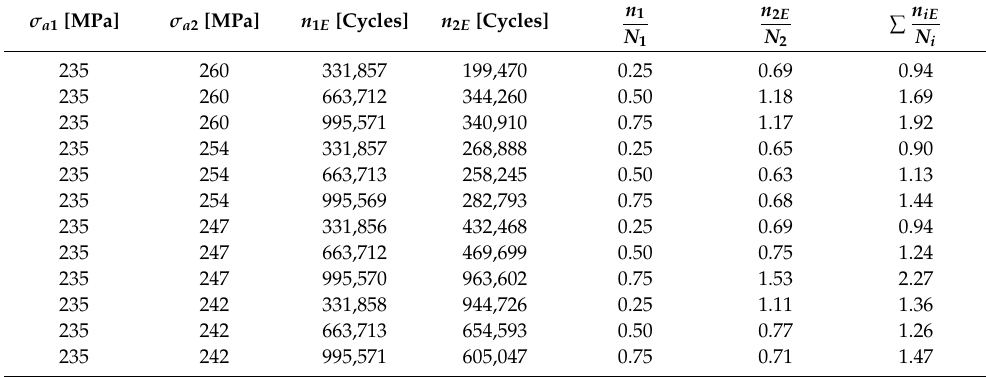
Table A5. Experimental results L–H block loading, specimens extracted from the transverse direction.